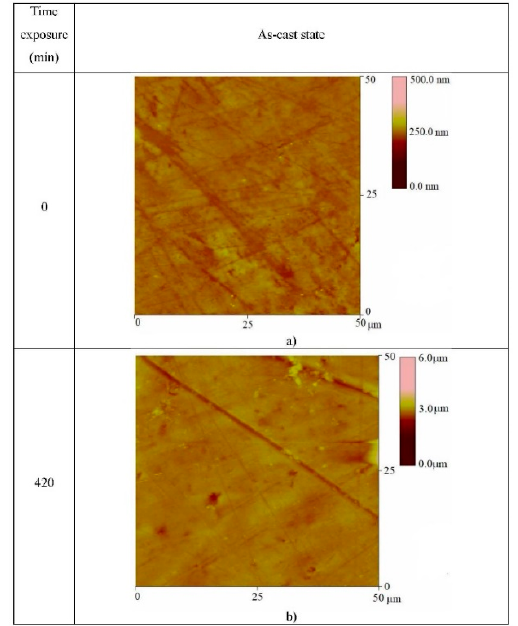
Figure 8. 2D AFM images of the sample in the as-cast state ( a ) before (50 × 150 × 0.5 μ m 3 ) and ( b ) after (50 × 50 × 6 μ m 3 ) cavitation testing for 420 min.